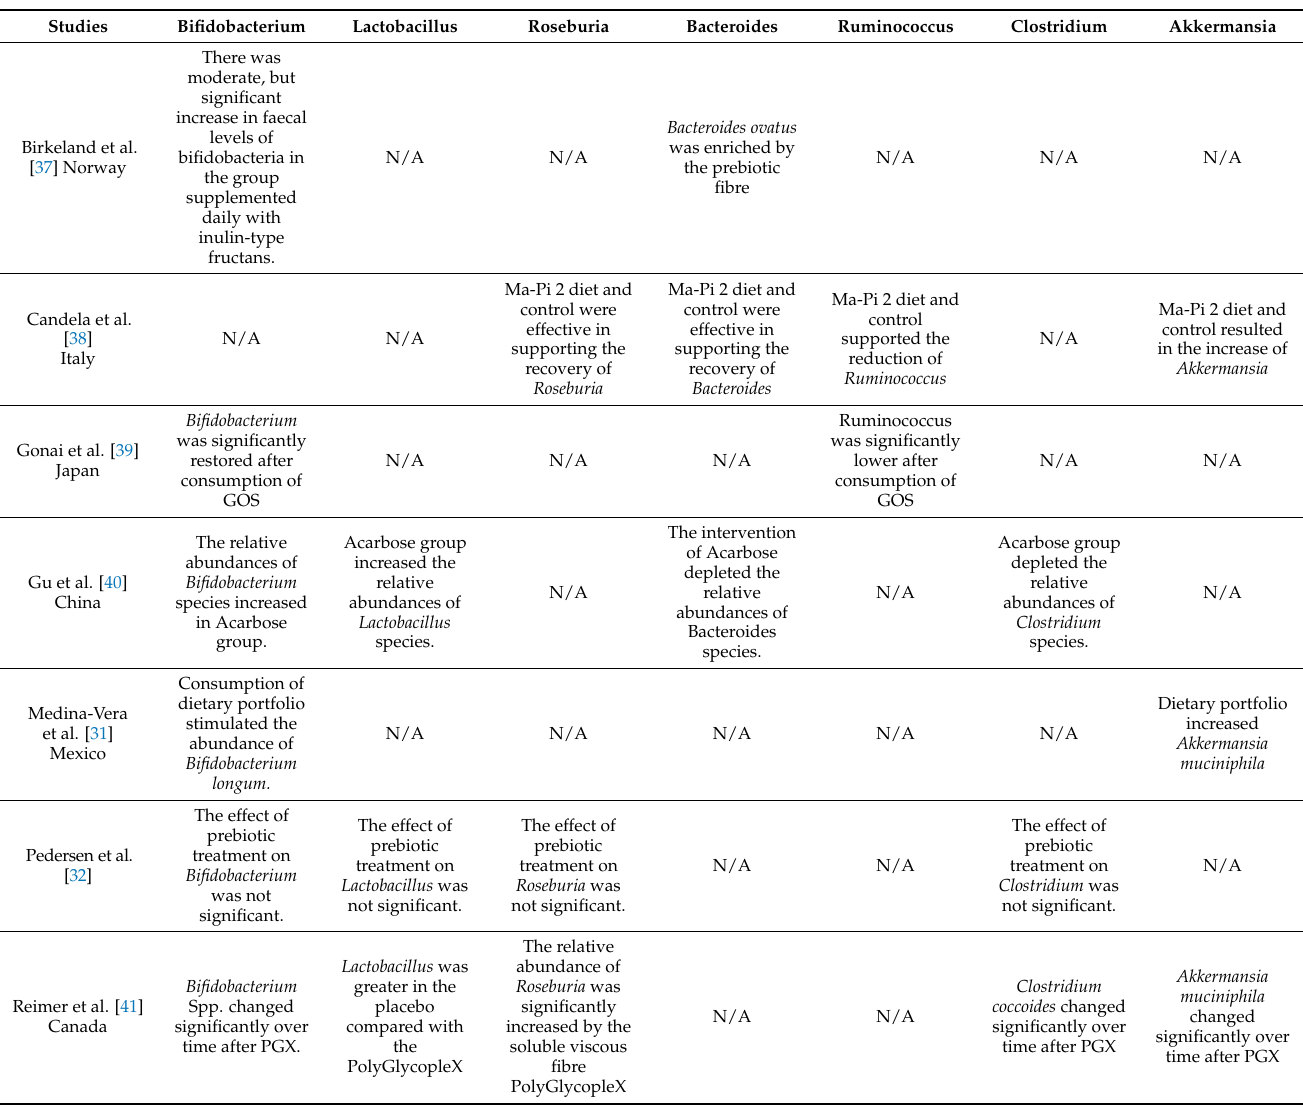
Table 3. Effects of prebiotics and Oral antidiabetic agents on gut